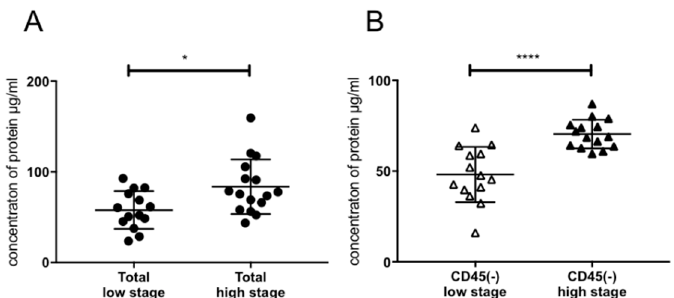
Figure 2. Exosomal protein concentration. ( A ) Protein concentration of total exosomes from plasma of high and low stage HNSCC patients, n = 30 ( B ) CD45( − ) exosome fraction of high and low stage patients, n = 29. p values were determined with Mann-Whitney test, with * p < 0,05, **** p < 0,0001. Bars represent mean with standard deviation (SD).